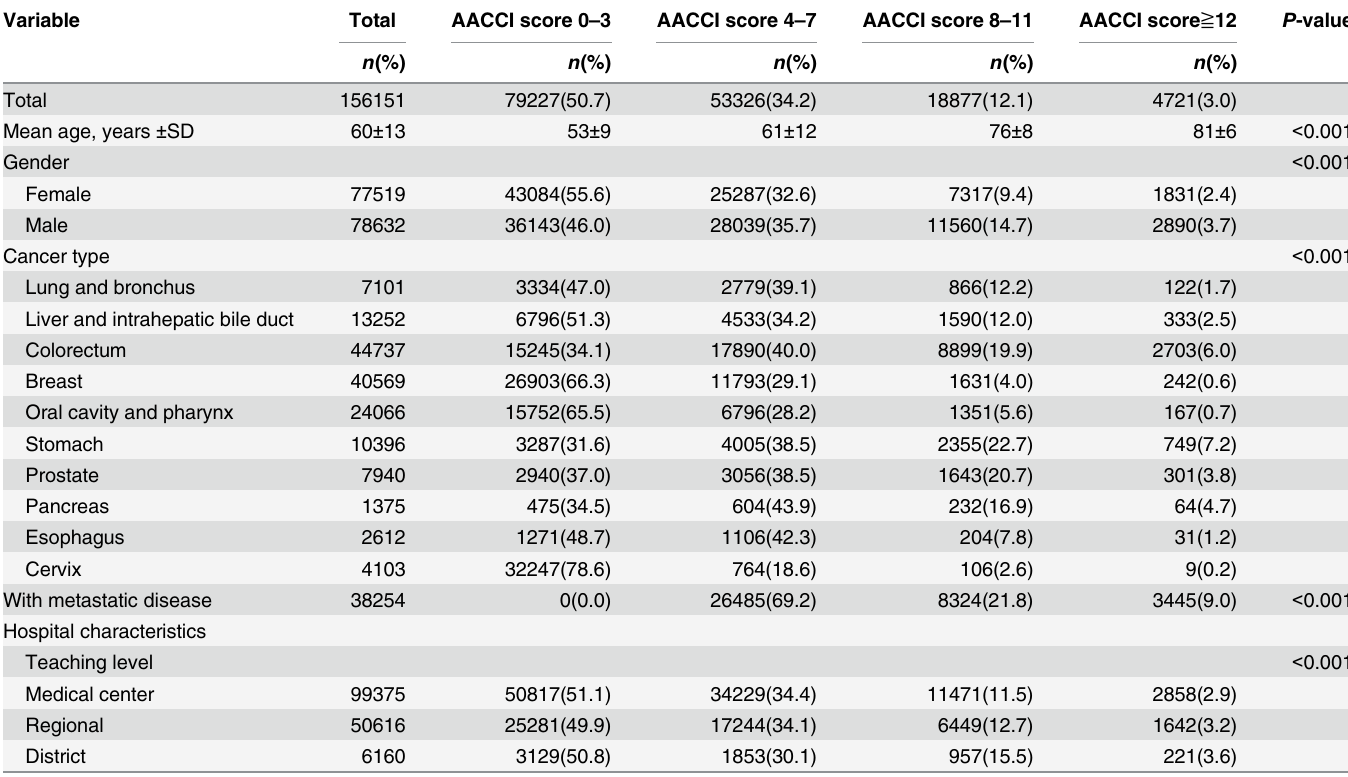
Table 4. Baseline characteristics of cancer surgery patients, n =